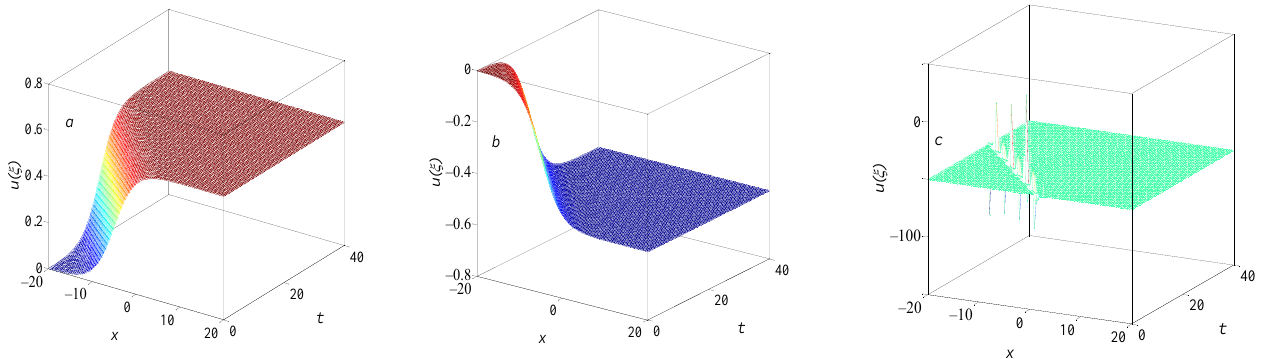
Figure 5. Three-dimensional plots of the solutions of Equation (44) when η = 1 and ε = 1; ( a ) δ = 1 and k = − 0.189; ( b ) δ = 1 and k = 0.189; and ( c ) δ = − 3 and k = 0.189.